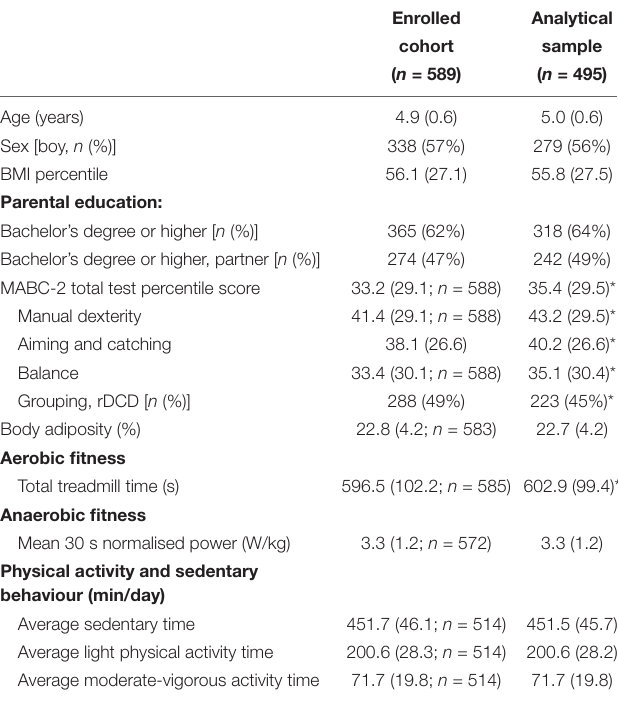
TABLE 1 | Cohort characteristics: demographics, health-related fitness, and physical activity.